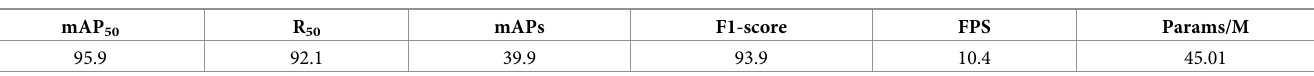
Table 4. Test result.